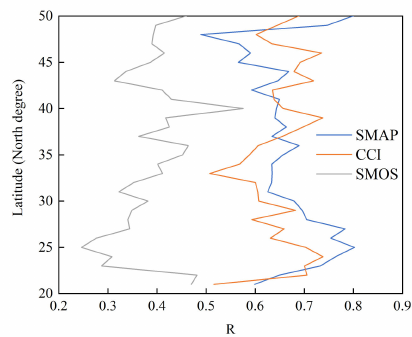
Figure 6. Latitudinal average distribution of performance in terms of R for SMAP, CCI, SMOS soil moisture